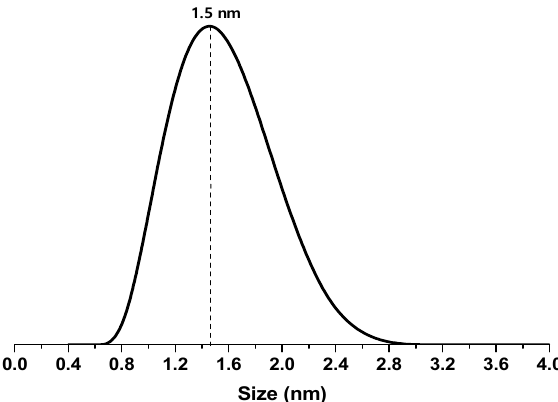
Figure 1. Hydrodynamic diameter distribution in the 0.56 M solution of titanium hydroxocomplexes. To identify the patterns of formation of fibrous TiO 2 during the flax fibre impregnation process,